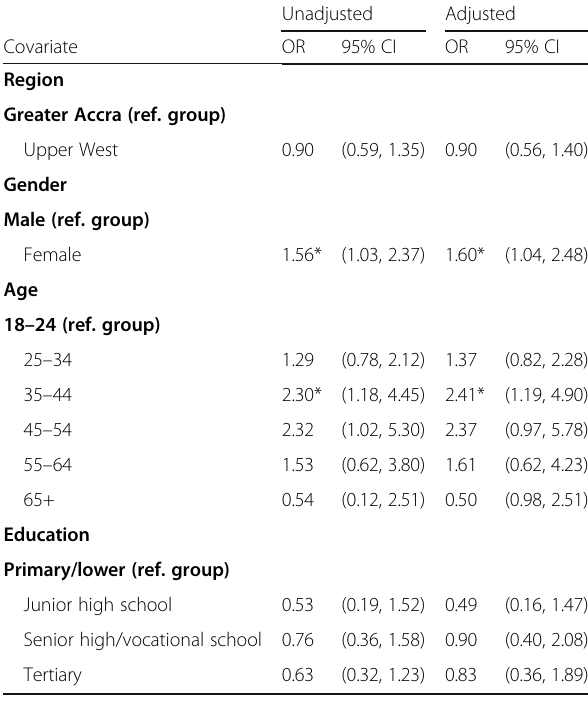
Table 5 Logistic regression results for Practices (n = 400) Unadjusted Adjusted Covariate OR 95% CI